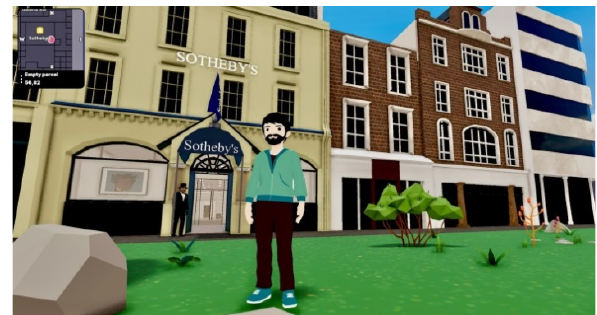
Figure 41: Prof Naseem Naqvi at Sotheby’s in the metaverse